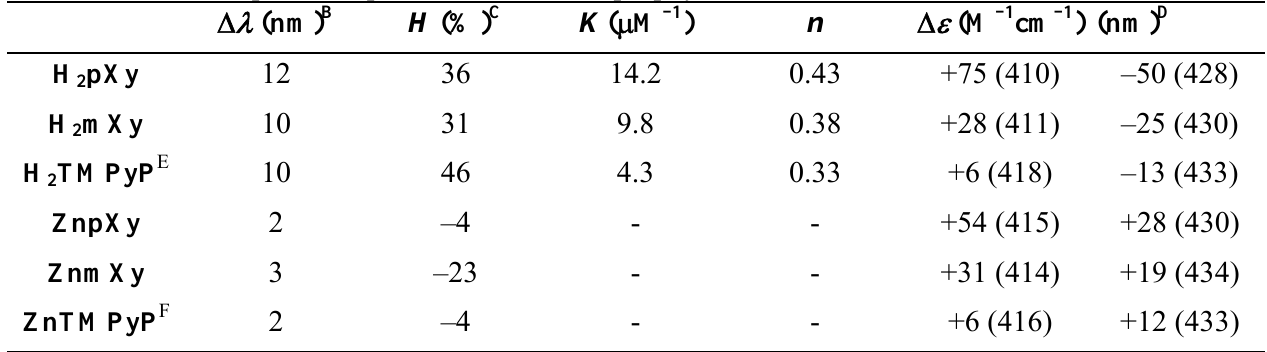
Table 1 . Spectroscopic data for cationic porphyrins bound to CTDNA in the buffer A